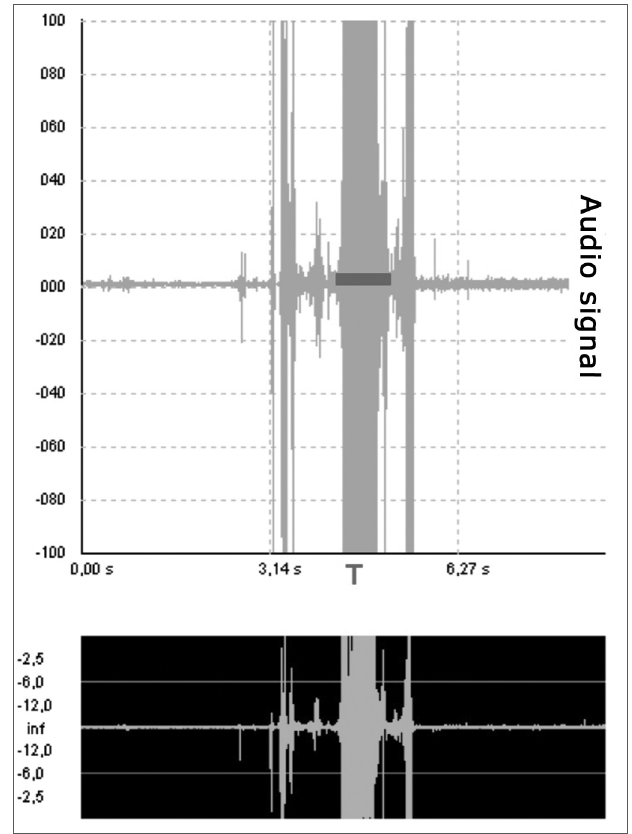
Figure 6. Swallowing